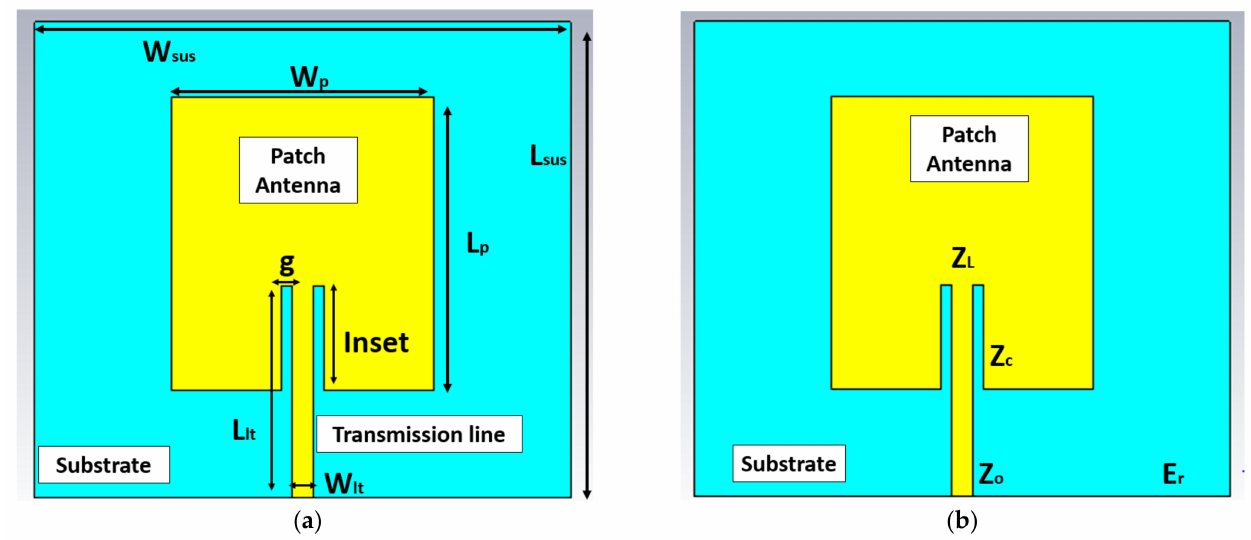
Figure 7. Both figures are microstrip feed with InsetFeed. ( a ) details of the sizing parameters, and ( b )